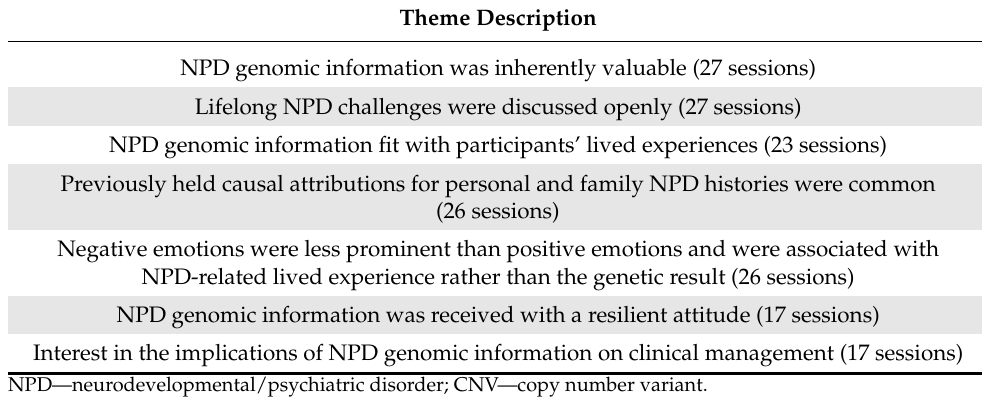
Table 2. Seven main themes representing participant responses to receiving NPD-related CNVs from 27 genetic counseling